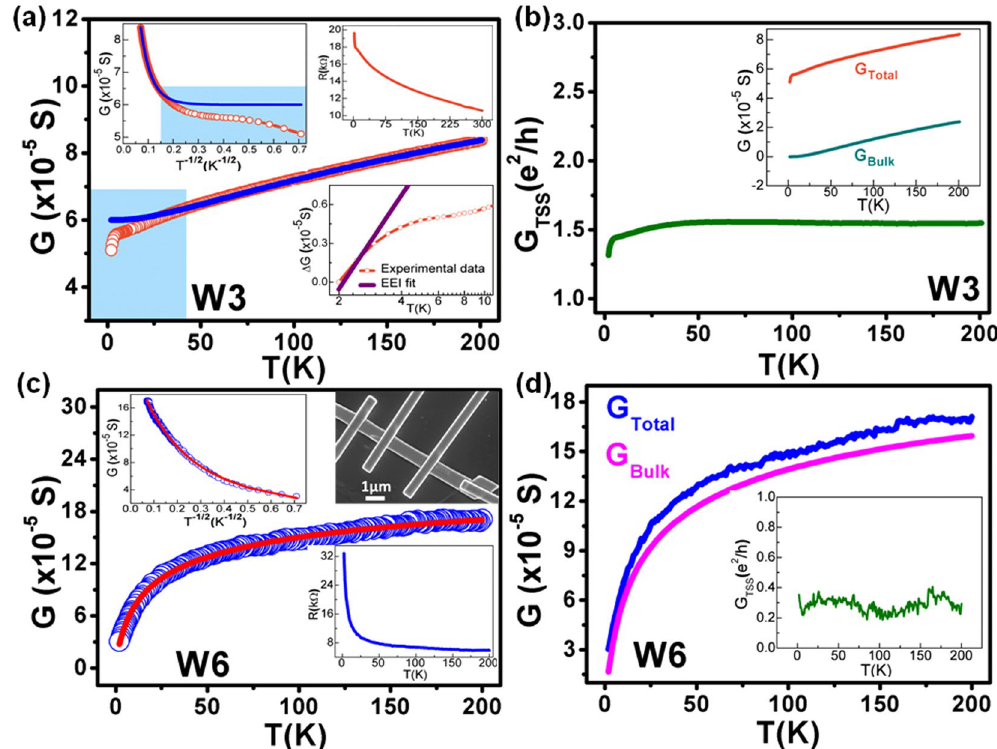
Figure 4. Variable range hopping transport mechanism in Bi 2 Se 3 nanowires under strong disorder regime. ( a ) Conductance versus temperature plot for device W3 (orange circles) with VRH fitting (blue solid line). Upper right inset shows the R-T cooling curve and lower inset shows the EEI fit at very low temperatures. Upper left inset is the G vs. T − 1/2 plot. The blue shaded region depicts the deviation in experimental conductance from VRH model. ( b ) TSS contribution to conductance is just above one conductance quantum ( e 2 / h ) for device W3. Inset shows the comparison between total conductance and bulk conductance. ( c ) Conductance (blue circles) for device W6 shows a monotonic decrease for complete temperature range. Upper left inset shows the G vs. T -1/2 behaviour. VRH fitting is shown in red colour. Lower inset shows the R-T cooling curve for the device. Upper shows the FESEM image of W6. ( d ) High bulk contribution is observed for the device W6. The TSS conductance is very low (~0.3 e 2 / h